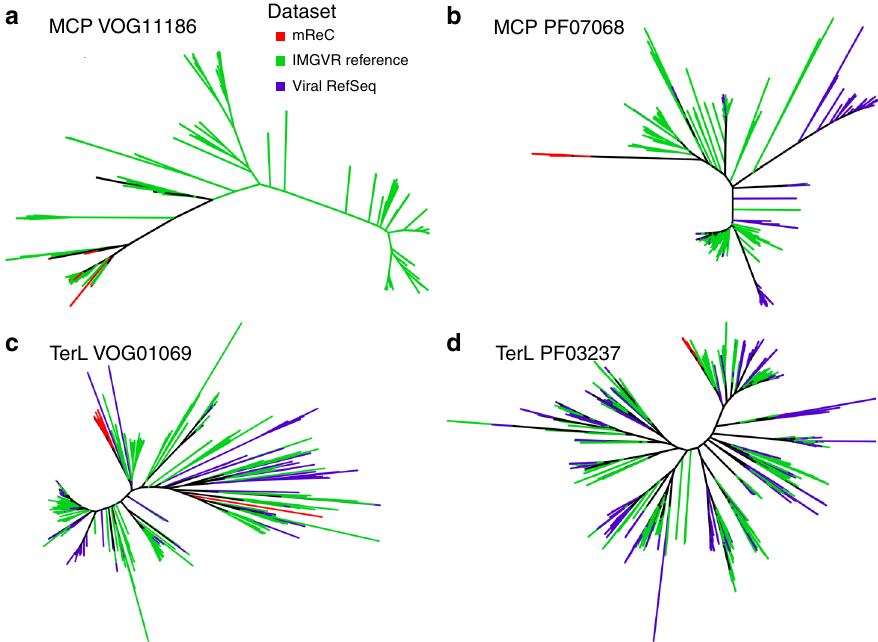
Fig. 5 Unrooted phylogenies of mReC capsid and terminase proteins together with references. a , b Phylogenies of the protein sequences for the major capsid protein (MCP) and c , d terminase large subunit protein (TerL) from the VOG ( a , c ) and Pfam ( b , d ) databases. Branch color corresponds to the source of the sequences. Instructions for accessing full trees with support values can be found in the “ Data availability ”